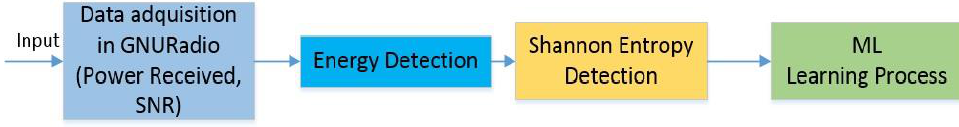
Figure 1. Proposed mixed entropy and energy detection for spectrum sensing.